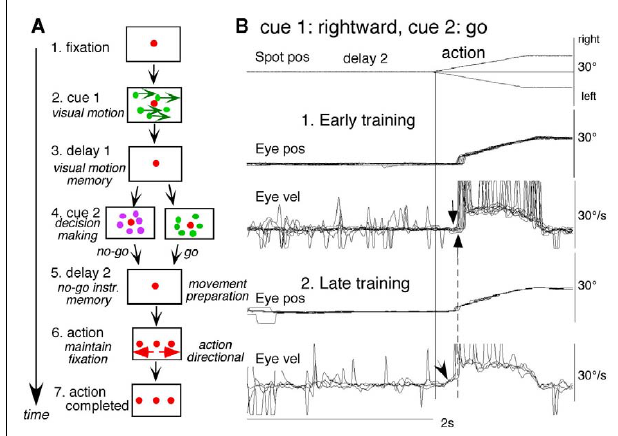
FIGURE 8 | Memory-based smooth-pursuit task and representative eye movements. (A) Schematic illustration of the task. A red stationary spot appeared at the screen center and the monkeys were required to fixate it [ (A1) fixation]. Cue 1 consisted of a random-dot pattern of 10˚ diameter. All 150 dots moved along one of 8 directions at 10˚/s for 0.5s [ (A2) cue 1, 100% correlation of Newsome and Pare, 1988].Visual motion–direction was randomly presented.The monkeys were required to remember both the color of the dots and their movement direction while fixating the stationary spot. After a delay [ (A3) delay 1], a stationary random-dot pattern was presented as the second cue for 0.5s [ (A4) cue 2]. If the color of the stationary cue 2 dots was the same as the cue 1 color, it instructed the monkeys to prepare to pursue a spot that would move in the direction instructed by cue 1 (i.e., go ). If the color of cue 2 differed from cue 1, it instructed the monkeys not to pursue (i.e., no-go ) but to maintain fixation of a stationary spot which required remembering the no-go instruction during the second delay [ (A5) delay 2]. Go/no-go cue was randomly presented. After the delay, the monkeys were required to execute the correct action by selecting one of three spots and either pursuing the correct spot in the correct direction or maintaining fixation [ (A6) action]. For this, the stationary spot remained centered, but spawned two identical spots; one that moved in the direction instructed by cue 1 and the other moved in the opposite direction at 10˚/s. For correct performance, the monkeys were rewarded. For analysis, all trials were sorted by cue 1, cue 2 direction/instructions. (B) Eye movement records during early and late training when cue 1 was rightward and cue 2 was go . Pos and vel indicate position and velocity. For further explanation, see text. Modified from Fukushima et al. (2008) and Shichinohe et al. (2009) with permission.